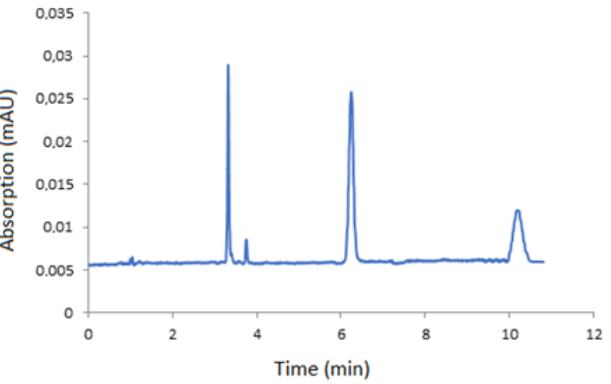
Figure 4. HPLC chromatogram after a 24 h adsorption study where peaks of remaining DBT, 4,6- DMDBT, as well as the polar DBT sulfone present in the effluent due to elution by acetonitrile, peaks: DBT-sulfone 3.31 min, unknown peak 3.76, DBT 6.23 min, and 4,6-DMDBT 10.24 min.